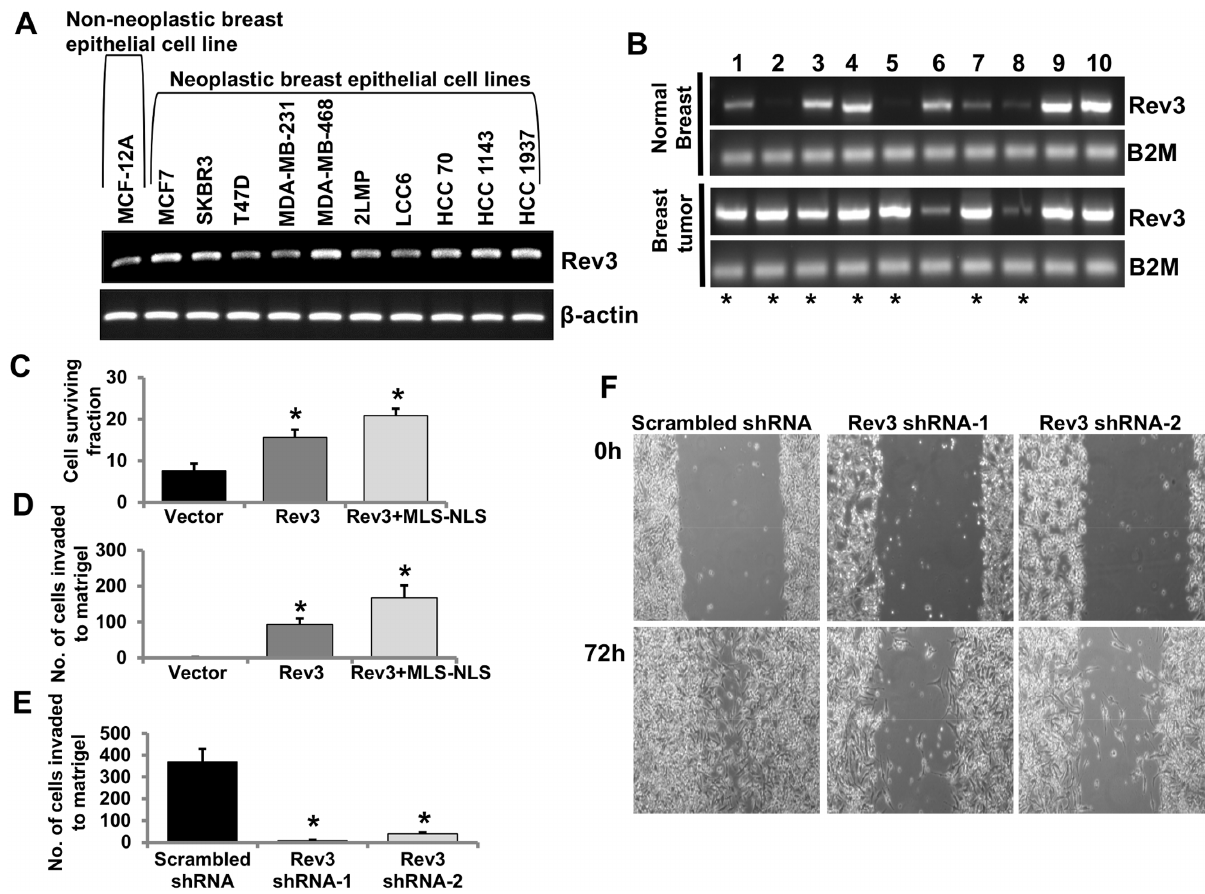
Fig 5. Mitochondrial REV3 contributes to tumorigenic properties. ( A - B ) RT PCR analysis of Rev3 gene expression in the non-neoplastic breast epithelial cell line MCF-12A and in 10 neoplastic breast epithelial cell lines ( A ), and in a set of 10 primary breast tumors and matched normal breast tissues from the same patients ( B ). Breast tumor samples showing increased mRNA expression of Rev3 compared to respective matched normal breast tissue are denoted by asterisks ( * ) ( B ). ( C - D ) Levels of survival ( C ) and Matrigel invasion capacity ( D ) of full-length Rev3 and Rev3+MLS-NLS expressing HEK293 cells. Bars represent mean ± s.d. * P < 0.05 versus vector-transfected cells; Student's t-test. ( E ) Matrigel invasion capacity of Rev3 shRNA-transfected HeLa cells (Rev3 shRNA-1 and Rev3 shRNA-2). Bars represent the mean ± s.d. * P < 0.05 versus scrambled shRNA-transfected HeLa cells; Student's t-test. ( F ) Comparison of cell-culture migration capacity of Rev3 shRNA-transfected HeLa cells (Rev3 shRNA-1 and Rev3 shRNA-2) with scrambled shRNA-transfected HeLa cells.